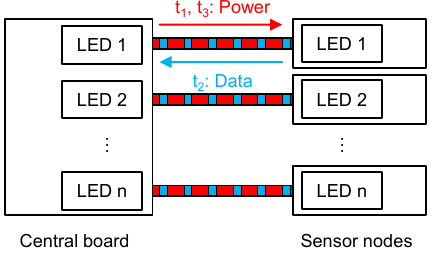
Figure 16. System concept using TDD for energy and data trans- mission.